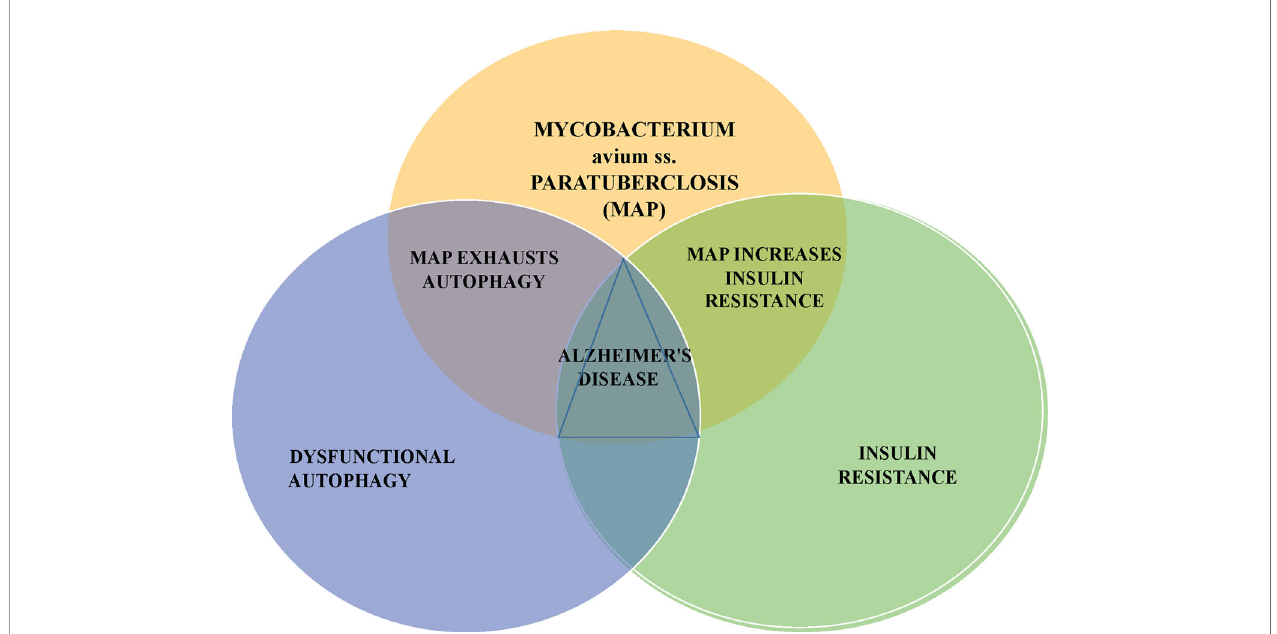
FIGURE 1 | MAP can impair autophagy and promote insulin resistance; these respectively, are the cellular and metabolic changes seen in Alzheimer ’ s disease. Mycobacterium avium subspecies paratuberculosis – MAP is a notable bacterium responsible for disease of animals, contamination of food and water and associated with an increasingly long list of human